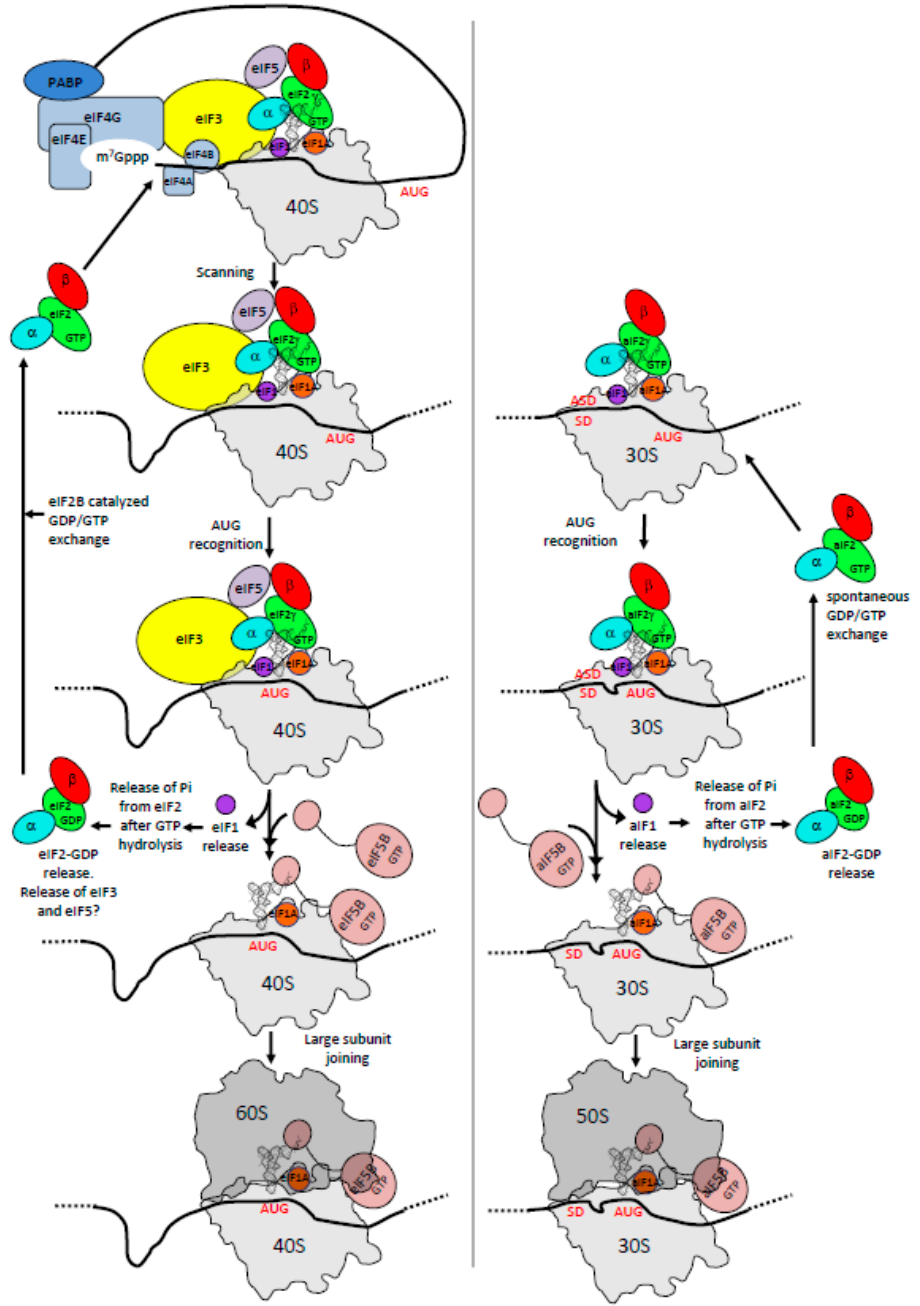
Figure 1. Schematic views of the translation initiation steps in eukaryotes and in archaea. The figure illustrates the main steps in the formation of the pre-initiation complex (PIC) in eukaryotes (left) and in archaea (right). The translation competent IC is formed after the release of e/aIF1A and e/aIF5B. The complex formed by eIF4E + eIF4G + eIF4A is known as eIF4F. Note that the e/aIF2 heterotrimer is represented with a three ‐ color code ( α subunit in blue, β subunit in red, γ subunit in green) for consistency with the other figures, highlighting the role of each subunit in the translation initiation. eIF3, composed of 6 (yeast) to 13 (mammals) subunits is represented as a single yellow oval to simplify the figure.